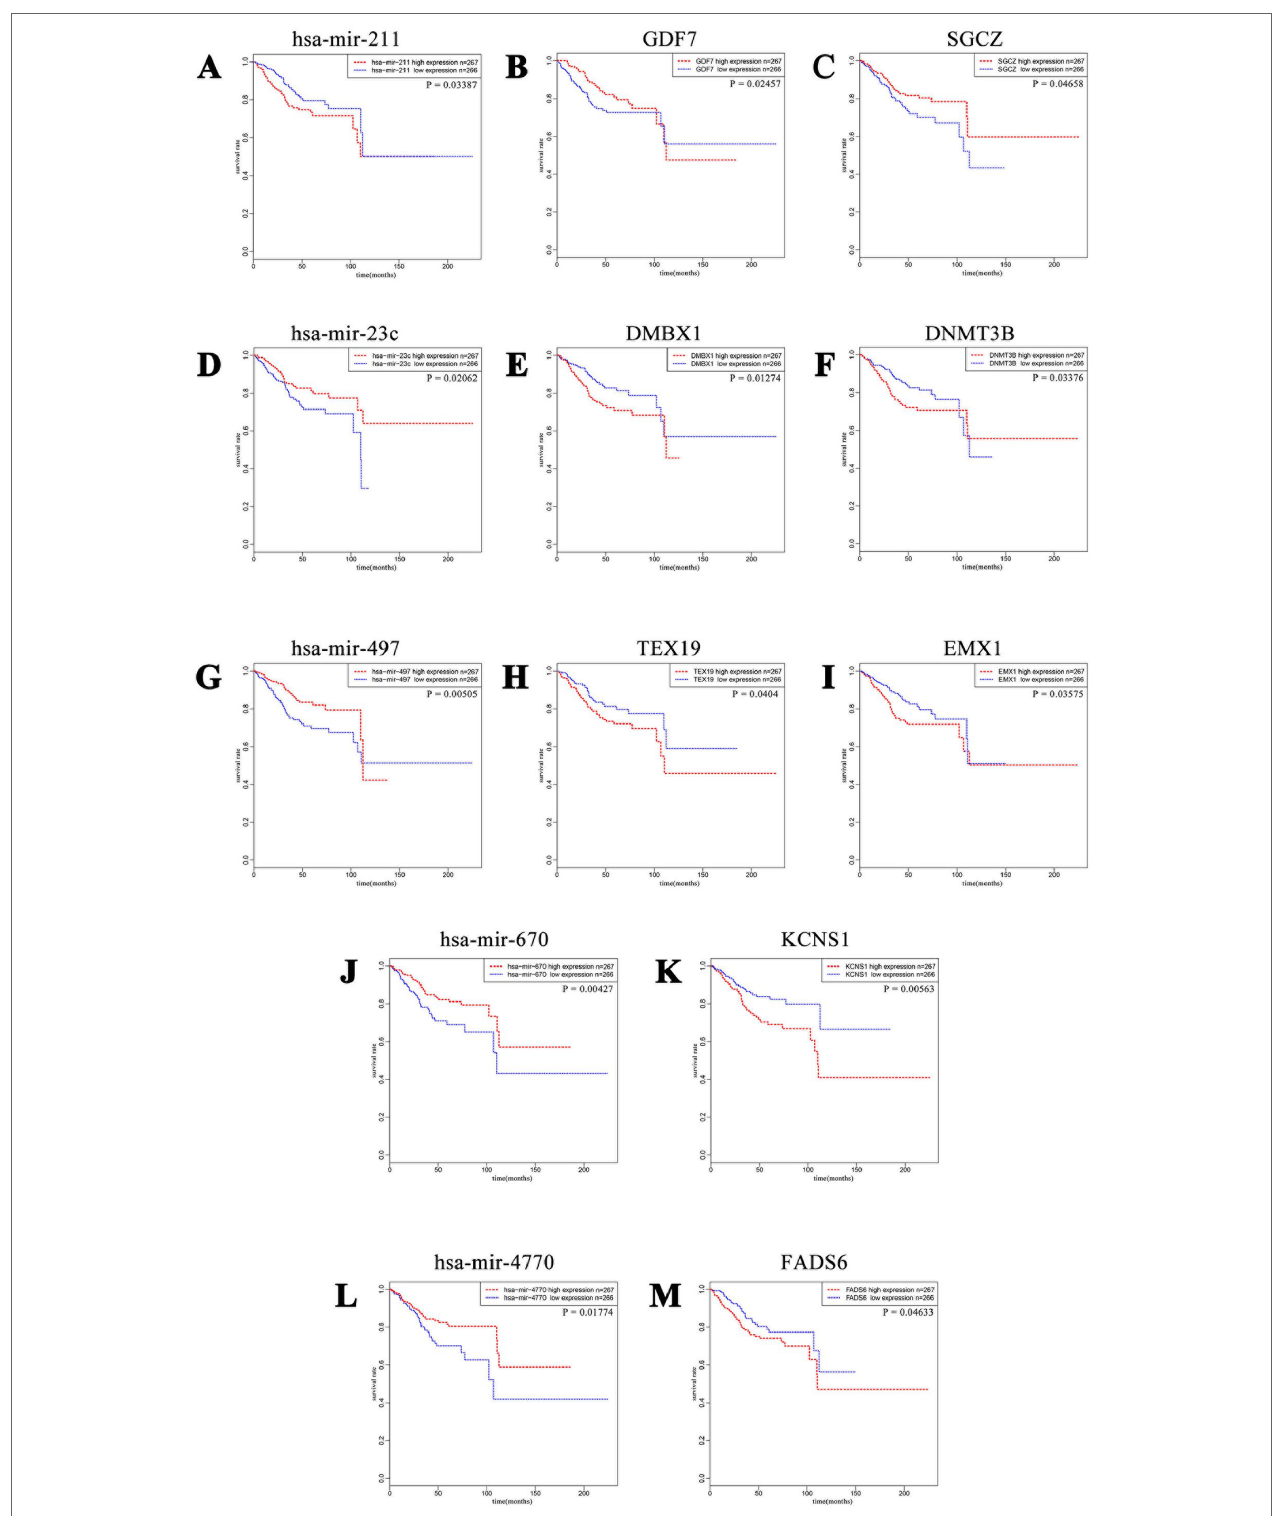
FIGURE 5 | Kaplan–Meier curves of five DE miRNAs and eight potential target DE mRNAs, with one upregulated miRNA (A) miR-211 paired with two downregulated mRNAs (B) GDF7 and (C) SGCZ) and four downregulated miRNAs (D) miR-23c, (G) miR-497, (J) miR-670, and (L) miR-4770) paired with six upregulated mRNAs (E) DMBX1, (F) DNMT3B, (H) TEX19, (I) EMX1, (K) KCNS1, and (M) FADS6). For each gene, patients were divided into high-expression group and low-expression group according to the median expression